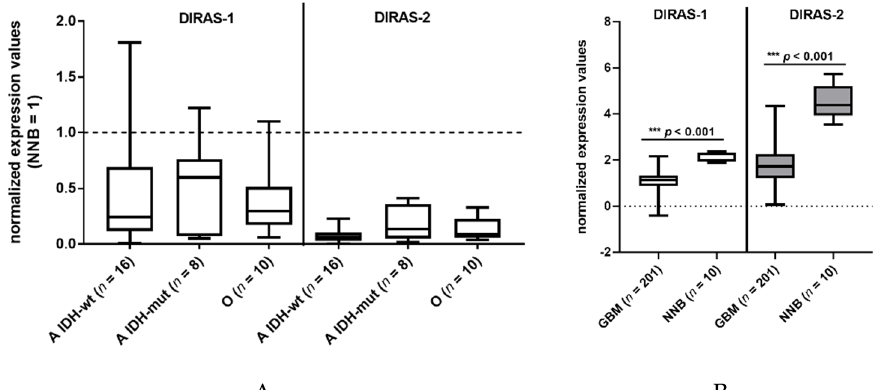
Figure 1. DIRAS-1 and DIRAS-2 expression in gliomas and non-neoplastic brain tissues. ( A ) Analy- sis of DIRAS-1 and DIRAS-2 mRNA expression in 34 glioma samples (A: astrocytic and O: oligoden- droglial tumors, IDH -wt: Wild-type IDH status, IDH -mut: mutated IDH status) ( B ) Analysis of DIRAS-1 and DIRAS-2 mRNA expression in data obtained from The Cancer Genome Atlas database (GBM: glioblastoma, NNB: non-neoplastic brain) [13].) Original figure in Figure S.